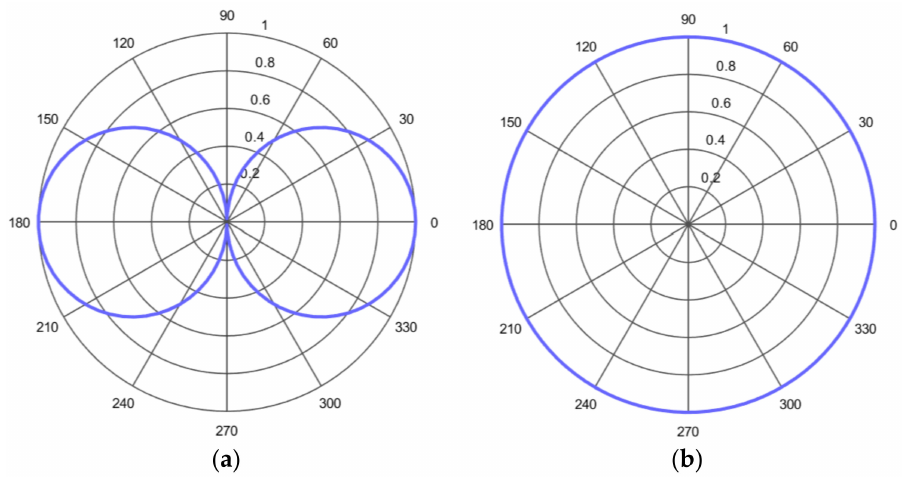
Figure 2. ( a ) The directional response of oriented directional sensor; ( b ) The directional response of omnidirectional